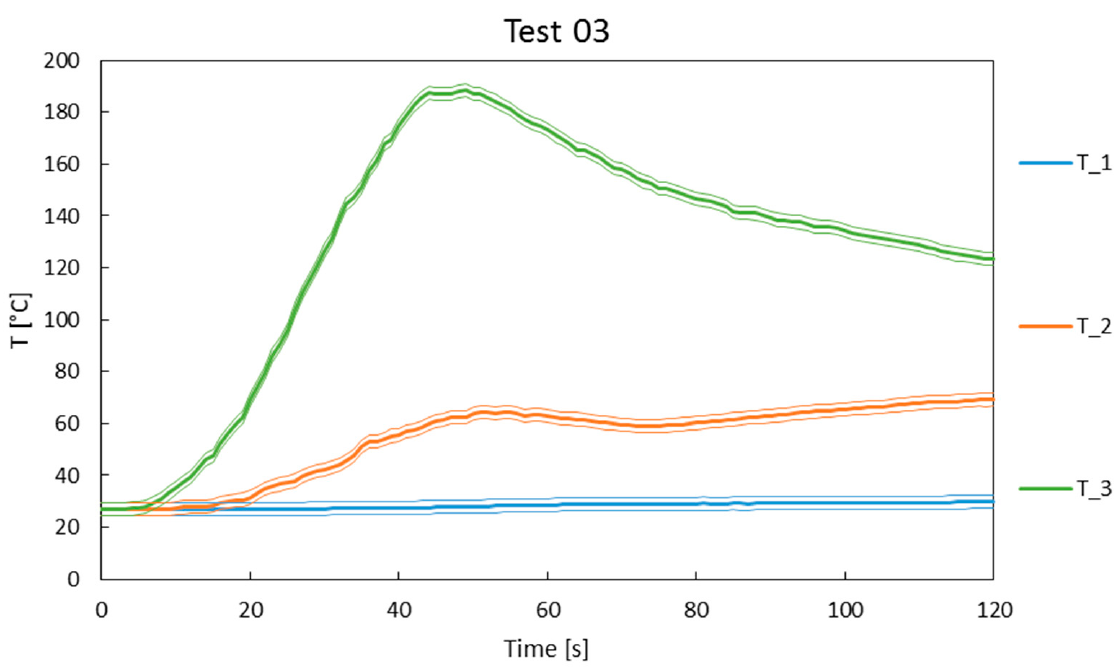
Fire 2022 , 5 , x FOR PEER REVIEW Figure 6. Evolution of temperatures in test 03. Figure 6. Evolution of temperatures in test 03.